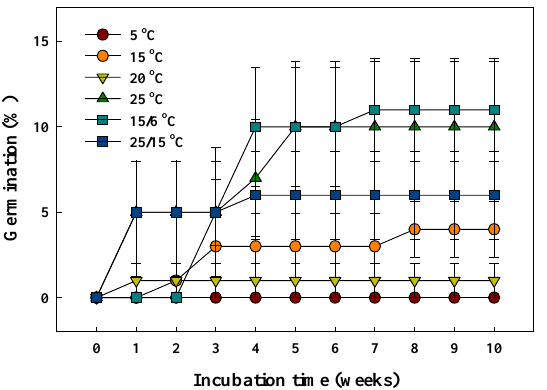
Figure 4. Cumulative germination of the Gentiana triflora var. japonica (Kusn.) H. Hara seeds in six temperature regimes (5, 15, 20, 25, 15/6, and 25/15 °C). Vertical bars represent the standard deviation from the mean ( n = 4).